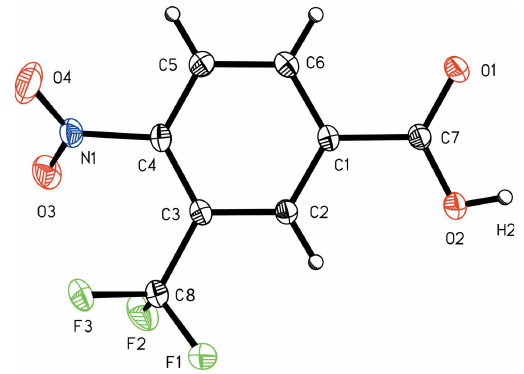
Figure 2 A view of 4-nitro-3-(trifluoromethyl)benzoic acid (II) with the atom- numbering scheme. Displacement ellipsoids are shown at the 50% probability level.